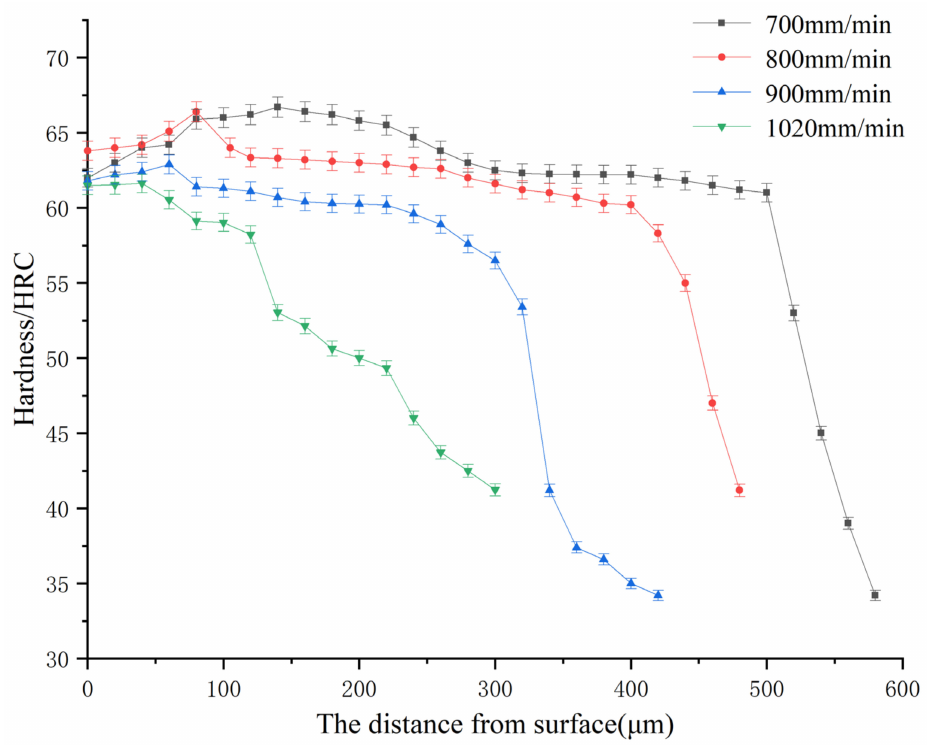
Figure 4. Variation in hardness of 40CrNiMo steel samples with distance from the surface under different scanning